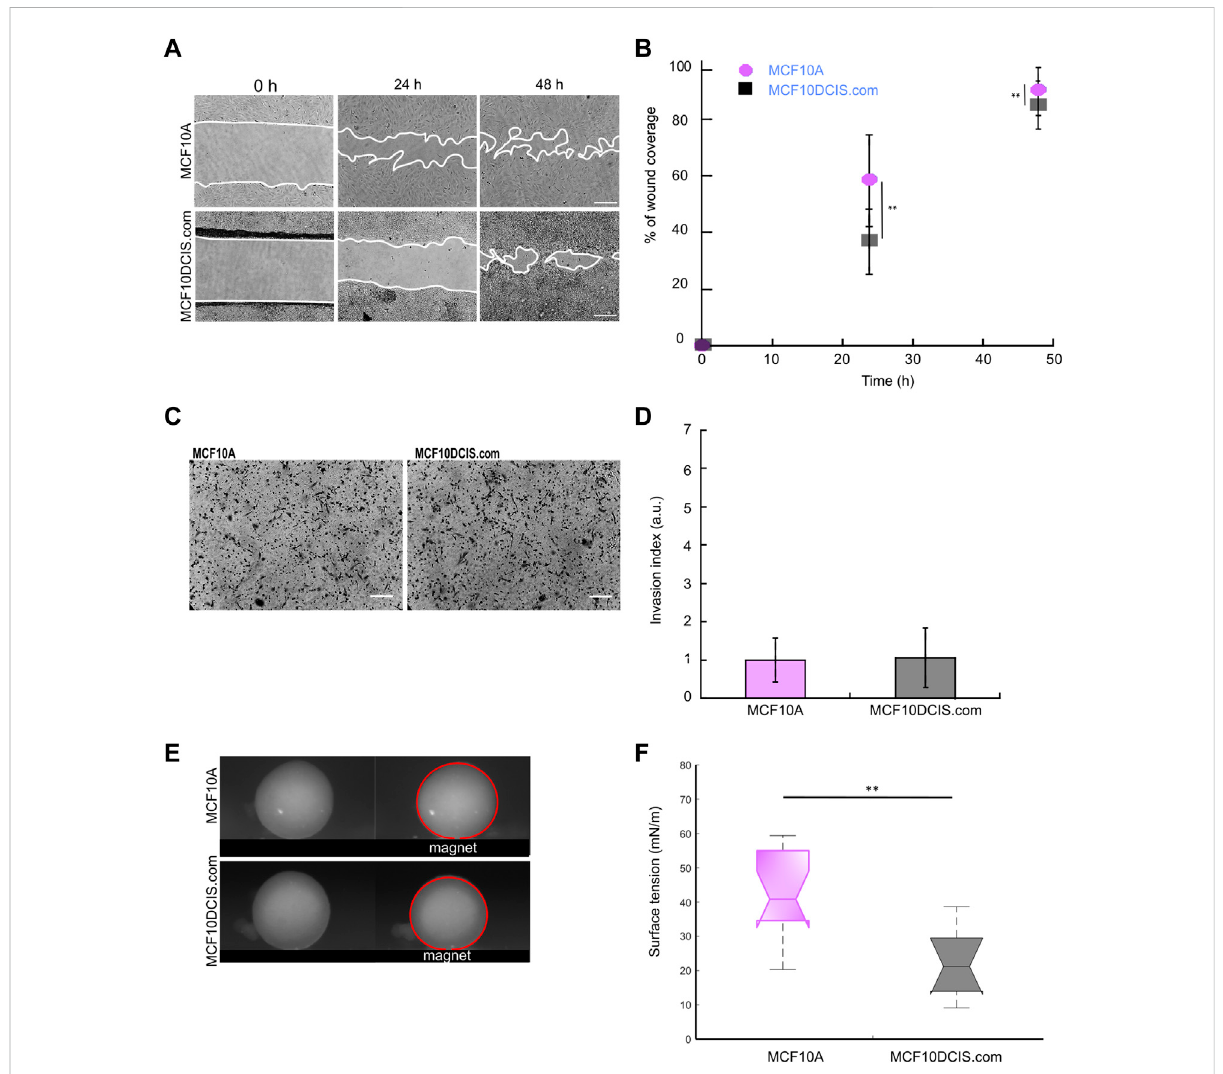
Frontiers in Cell and Developmental